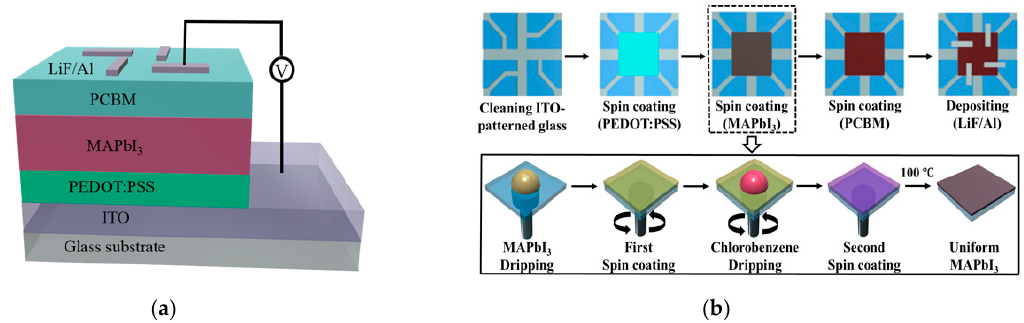
Figure 3. ( a ) Schematics of the constructed bulk heterojunction preoskite device, ( b ) Fabrication procedure of the perovskite detector and solvent engineering procedure for preparing the uniform and dense perovskite film.